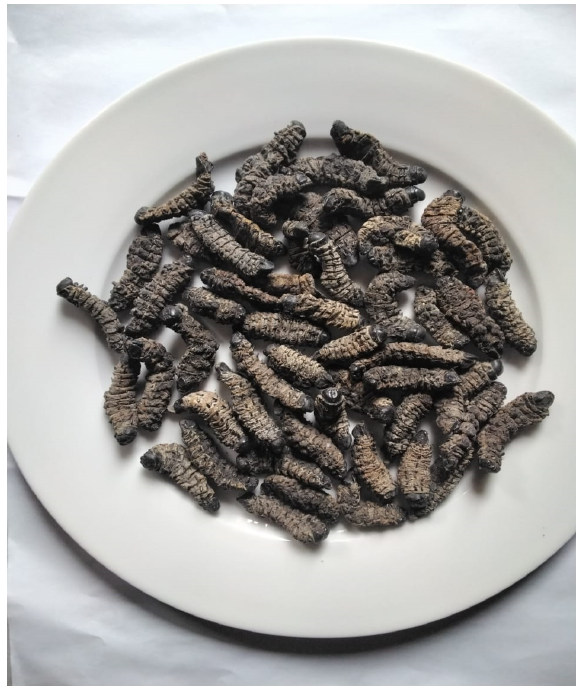
Figure 1. Mopane worms ( Gonimbrasia belina).